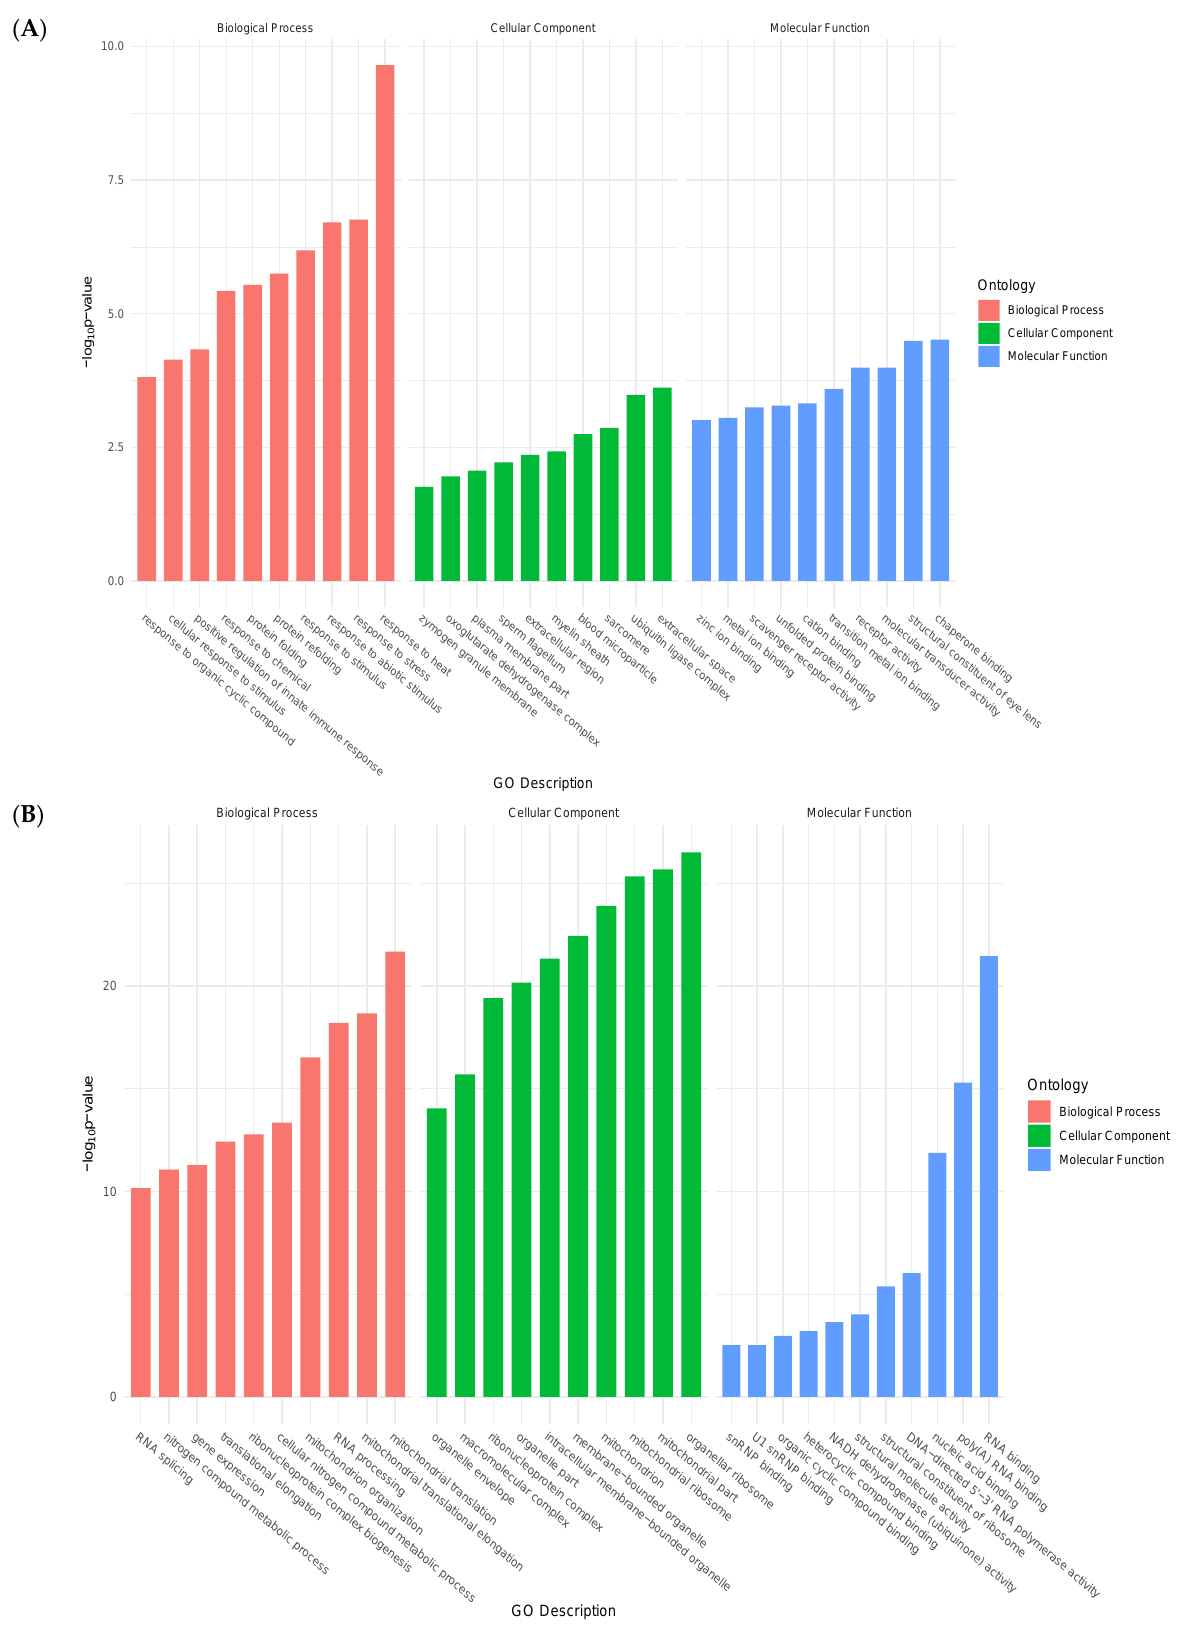
Figure 2. Bar plots showing top ten enriched functional terms for upregulated genes ( A ) and downregulated genes ( B ) at 24 h post-collagenase treatment.